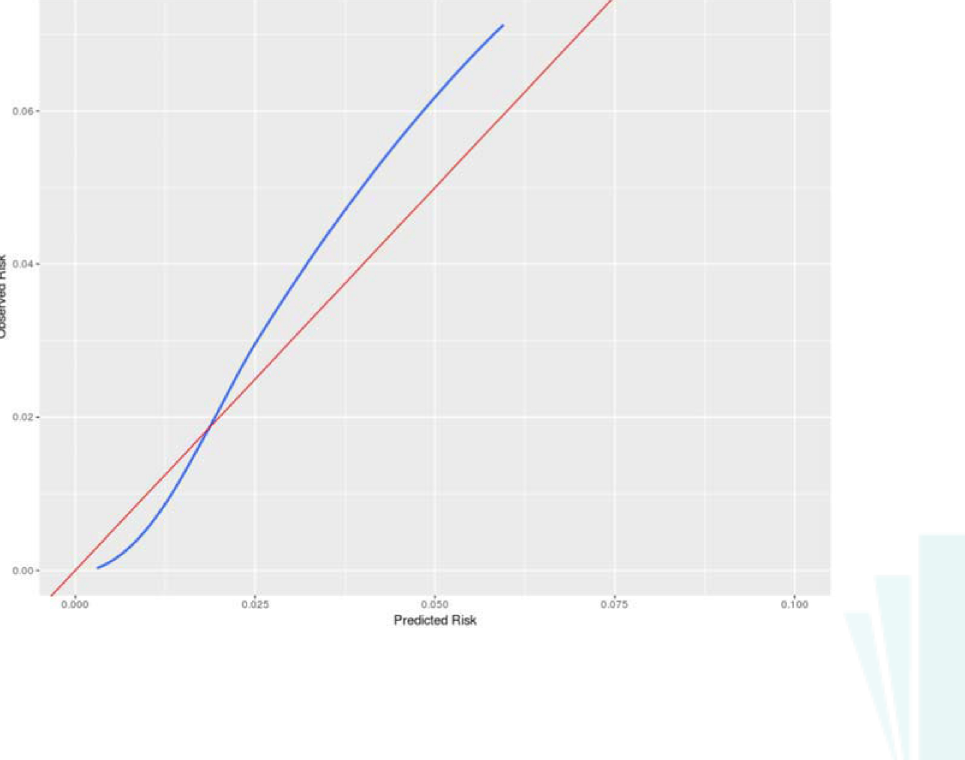
Appendix Figure 2c: Calibration plot for